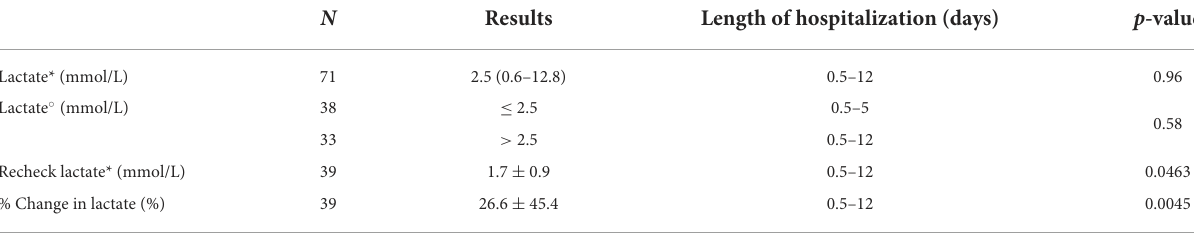
TABLE 3 Prognostic value of admission lactate concentration, recheck lactate concentration, and percent change in lactate concentration in cats presented with respiratory distress to predict the length of hospitalization. N